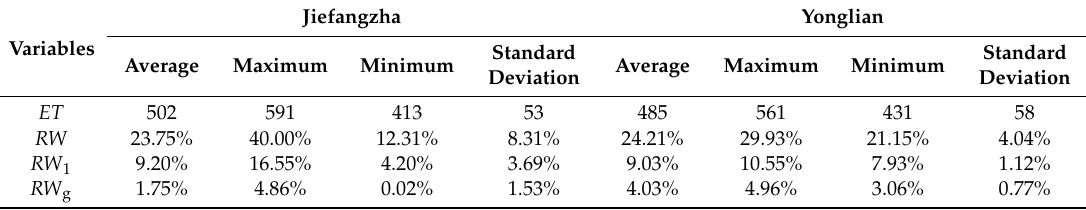
Figure 10. Results of the actual evapotranspiration ( ET ), precipitation and contributions of ground water utilization ( RW g ), soil ‐ ground water storage utilization below 1 m soil depth ( RW 1 ), and soil ‐ ground water storage utilization ( RW ) to the actual evapotranspiration in Jiefangzha and Yonglian. ( a ) and ( c ) Results of the actual evapotranspiration ( ET ) and precipitation in Jiefangzha and Yonglian, respectively. ( b ) and ( d ) Results of the contributions of the water storage utilizations to the actual evapotranspiration in Jiefangzha and Yonglian, respectively. Table 5. Statistical results of ET , RW , RW 1 and RW g in Jiefangzha and Yonglian.